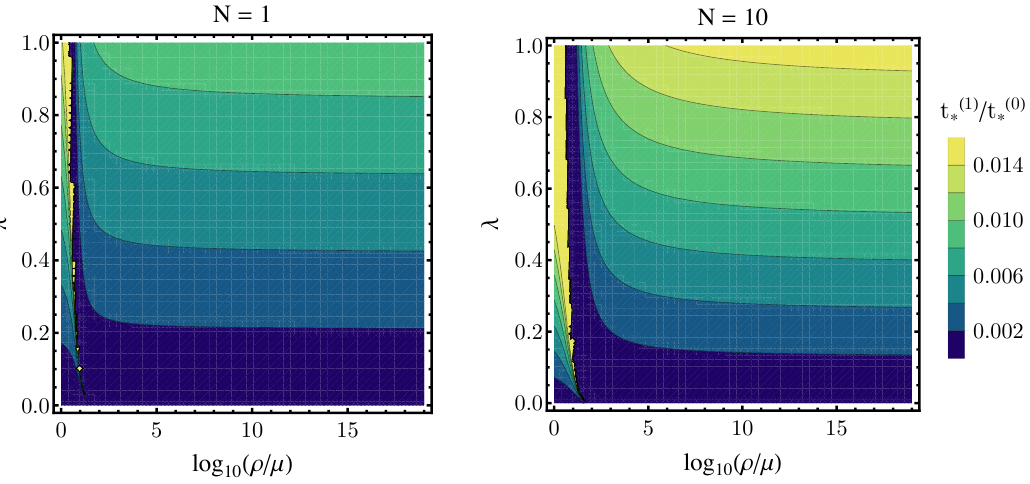
Figure 8 . Contour plot of the ratio t (1) (cid:3) =t (0) (cid:3) for N = 1 (left) and N = 10 (right) scalar (cid:12)elds as a function of the coupling (cid:21) and the decimal logarithm of the ratio (cid:26) for both of the